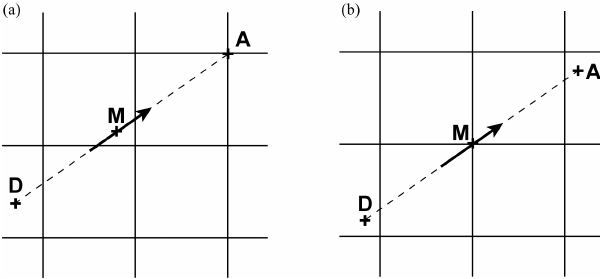
Figure 1. Schematic of two-dimensional advection for (a) the traditional backward semi-Lagrangian scheme and (b) the NDSL scheme. “D,” “M,” and “A” indicate the departure point, midpoint, and arrival point, respectively. The bold arrow indicates the wind vector at the